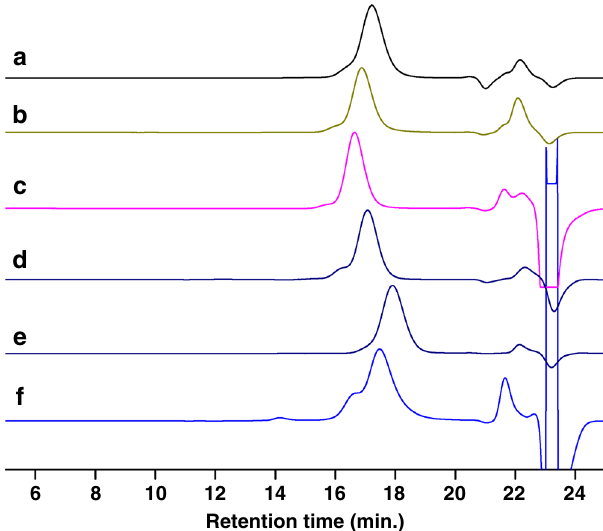
Fig. 6 Representative GPC traces of PGAC samples from Table